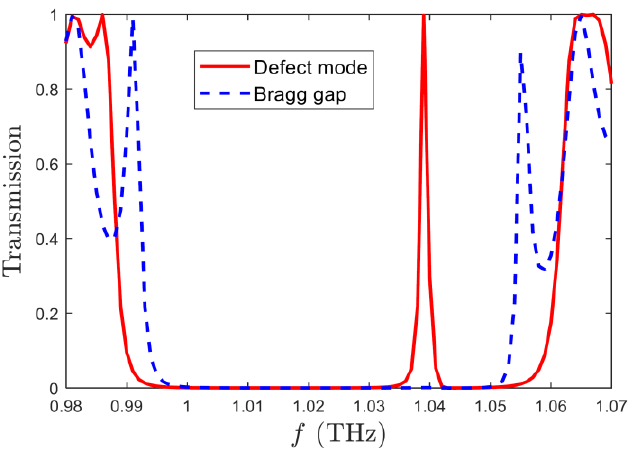
Figure 2. Spectra of planar THz waveguides with (the solid red line) and without (the blue dashed line) defects.